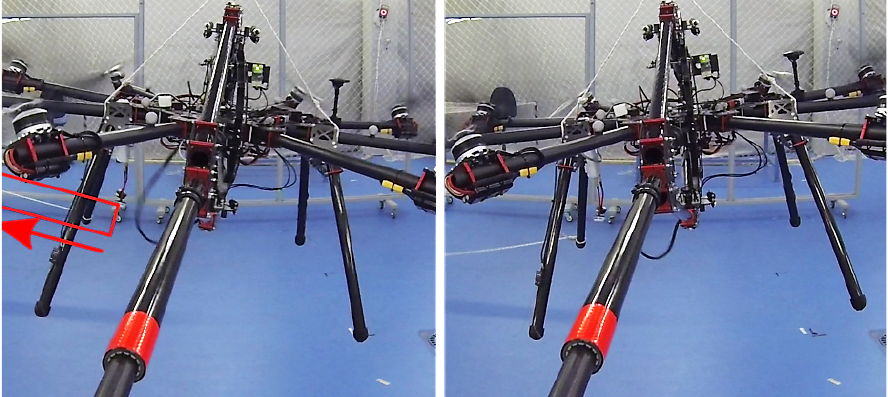
Figure 11. Two images from the video at https://youtu.be/mp4UAuhNHWc taken during the robustness analysis experiments. The safety rope with negligible tension is shown at the